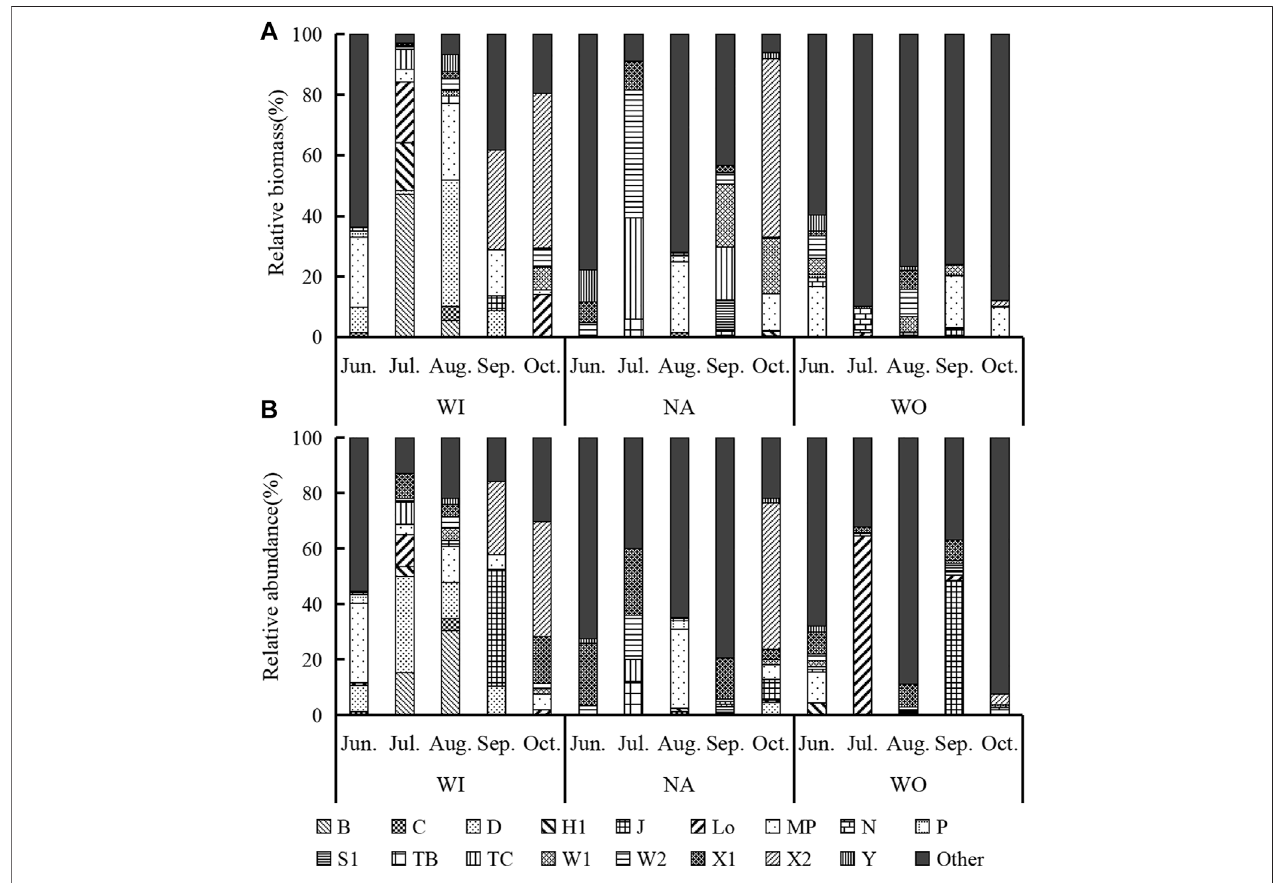
FIGURE 6 | Relative biomass (A) and relative abundance (B) of phytoplankton functional groups.